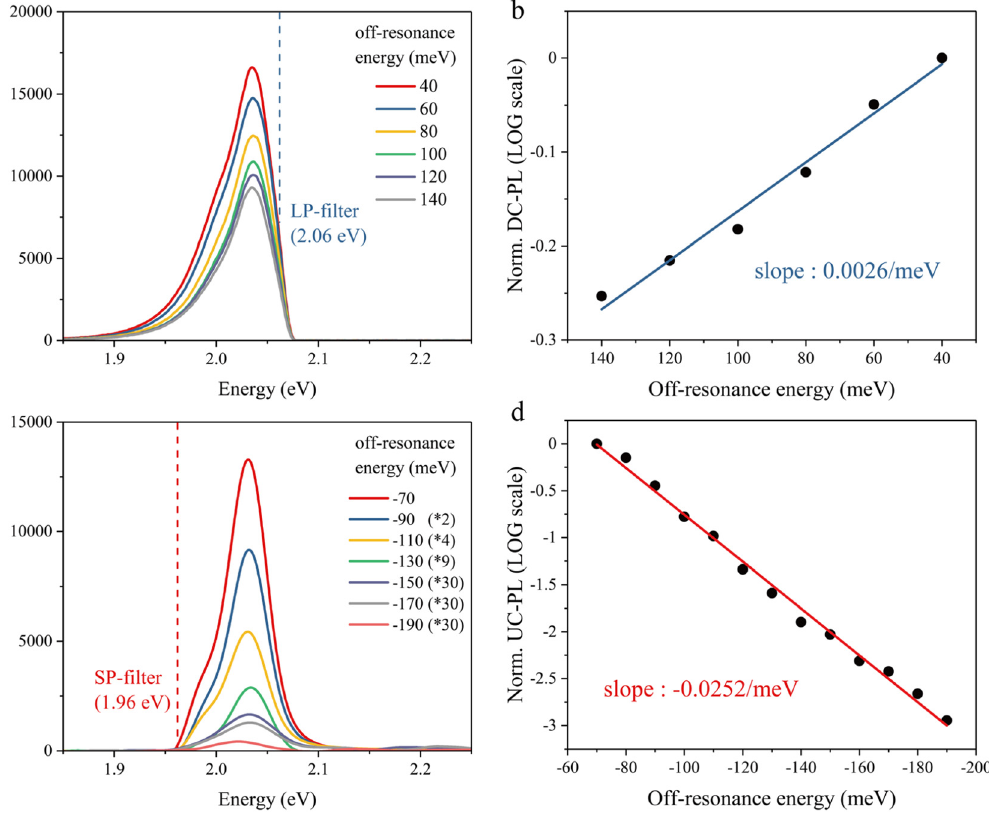
Figure 2: Photoluminescence excitation (PLE) spectra in downconversion (DC) and upconversion (UC) processes. (a)DCPLand(c)UCPLspectraundervariableexcitationenergy.Normalizedintensityof(b)DCPLand(d)UCPLinlogscale,linearlydepending on the off-resonance